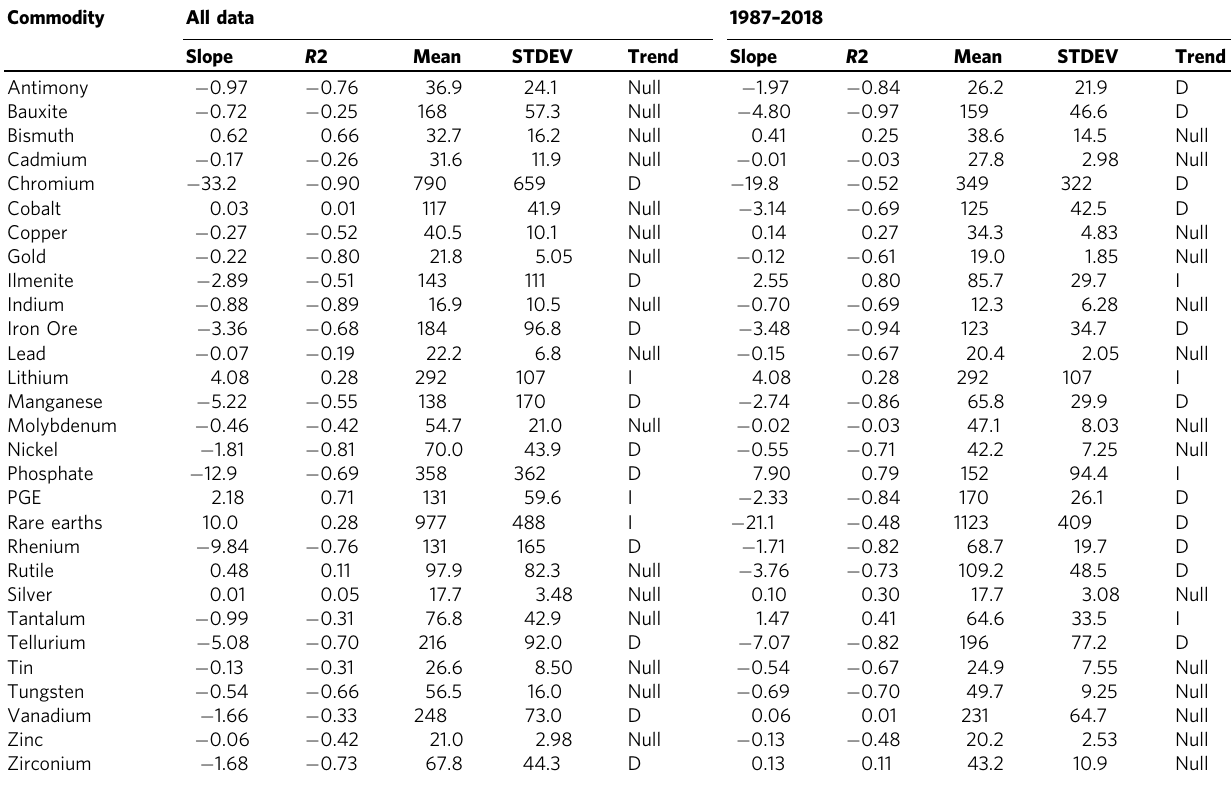
“ Slope ” indicates the slope of the least-squares best fi t line for the data in question, R 2 indicates the correlation coef fi cient between reserve/production data and time. STDEV or standard deviation documents the variation in the data, and “ Trend ” indicates the overall trend of the slope of the reserve/production ratio best fi t line over time, with I = slope increasing by >1, D = slope decreasing by < − 1, and Null = change of either <1 or > −